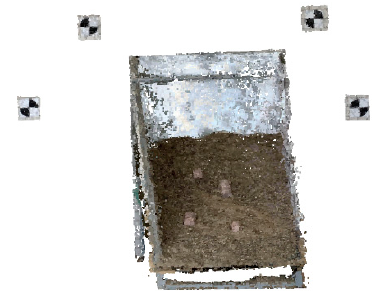
Figure 14. The results after iterative closest point (ICP) registration.